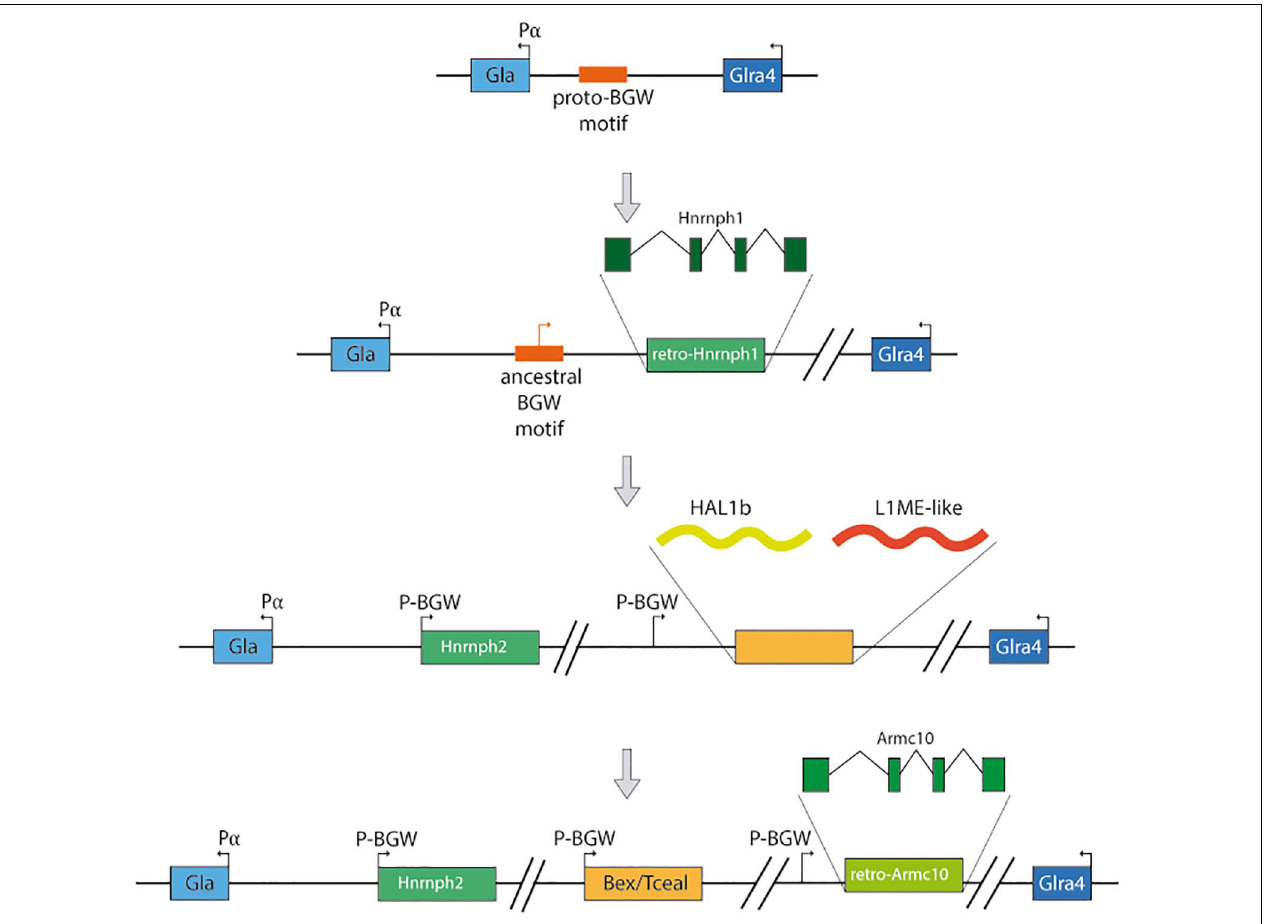
FIGURE 4 | Proposed steps for the Bex/Tceal cluster